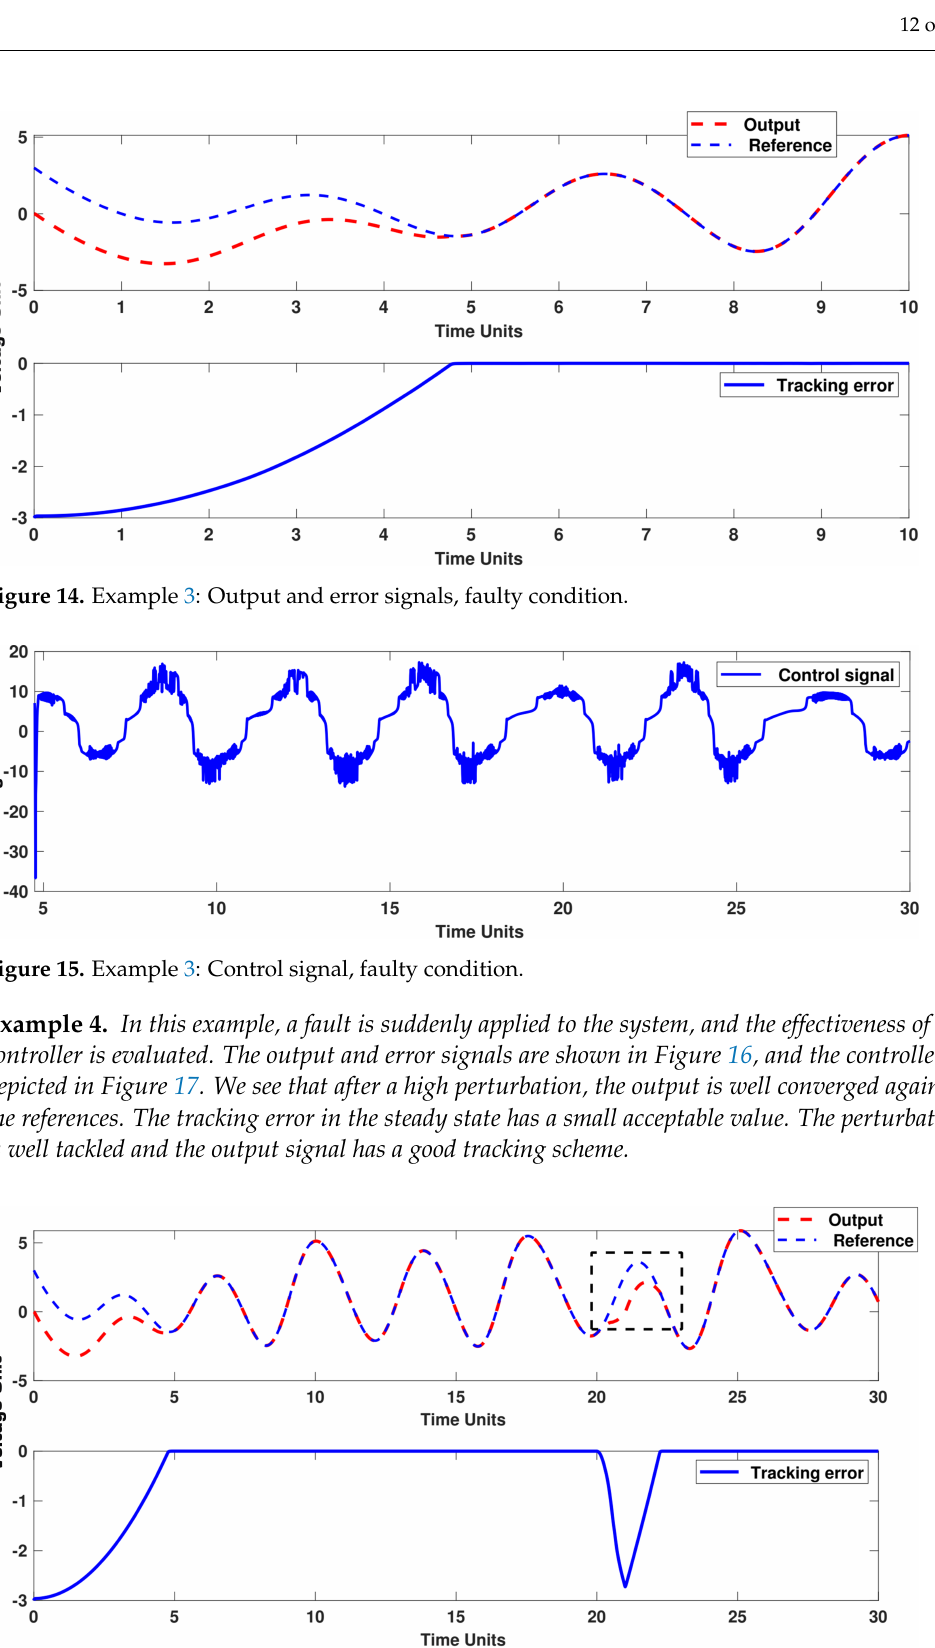
Figure 16. Example 4: Output and error